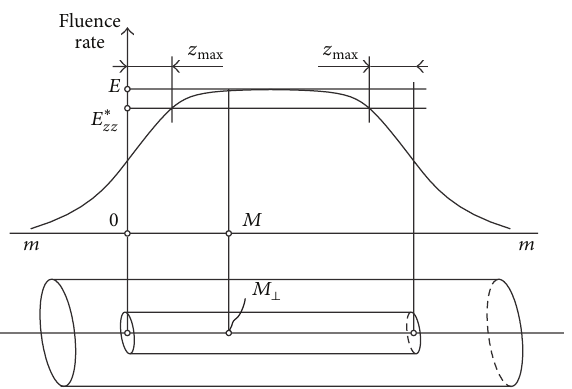
Figure 7: The fluence rate from the cylindrical source of finite length. The plot is given without scale